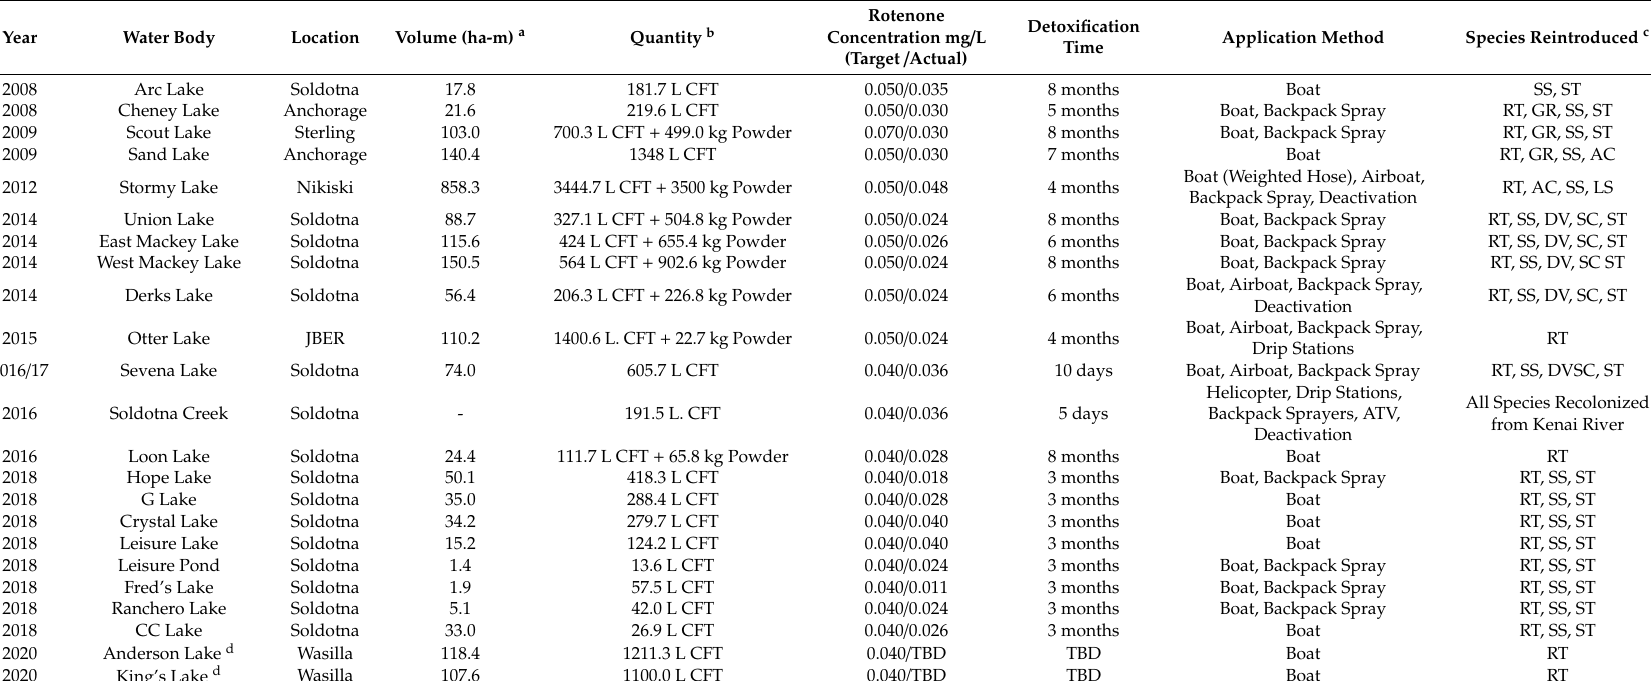
Table 1. Rotenone Applications for Invasive Northern Pike Removal in southcentral (SC)